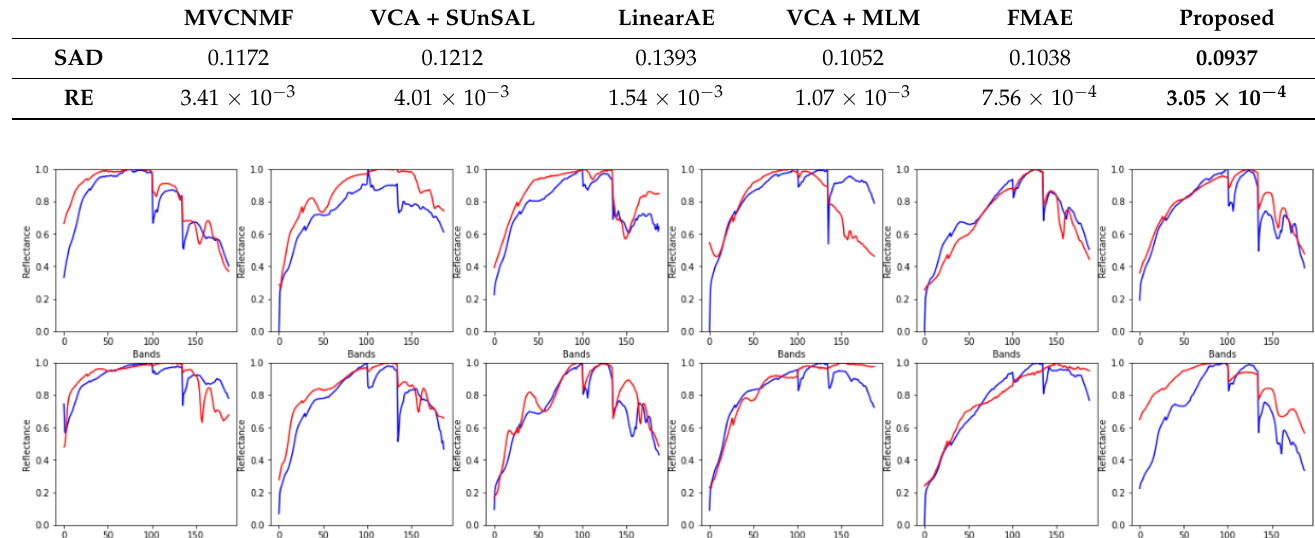
Table 6. Comparison of different methods on cuprite. Best results are reported in bold.